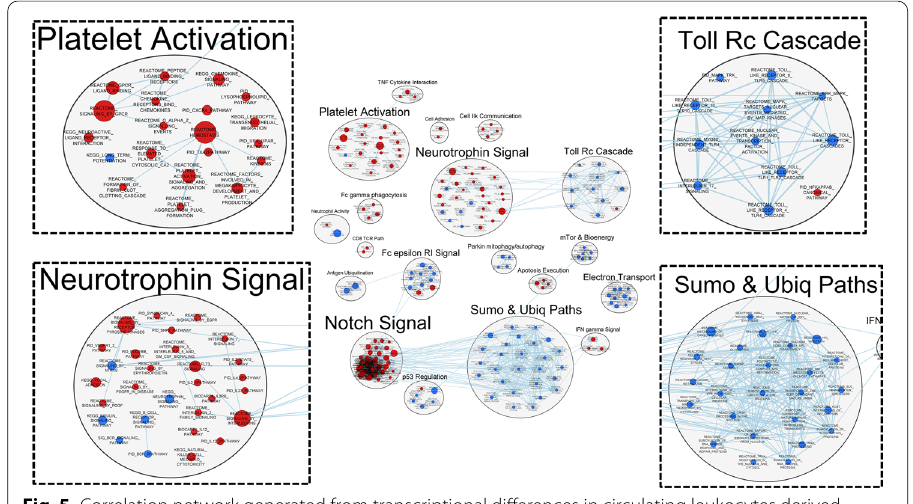
Fig. 5 Correlation network generated from transcriptional differences in circulating leukocytes derived from COVID19 and COVID19 critically ill patients. Each node represents a unique gene set and the + − edges represent the coefficient of similarity between gene sets above a defined threshold. Markov Cluster Algorithm (MCL) clustering analyses revealed groups of gene transcript nodes, where platelet activation, neurotrophin signalling, toll-like receptor signalling cascades, and sumoylation/ubiquitination pathways were identified as the top four nodes. Red indicates positive enrichment of gene transcripts and blue indicates negative enrichment of gene